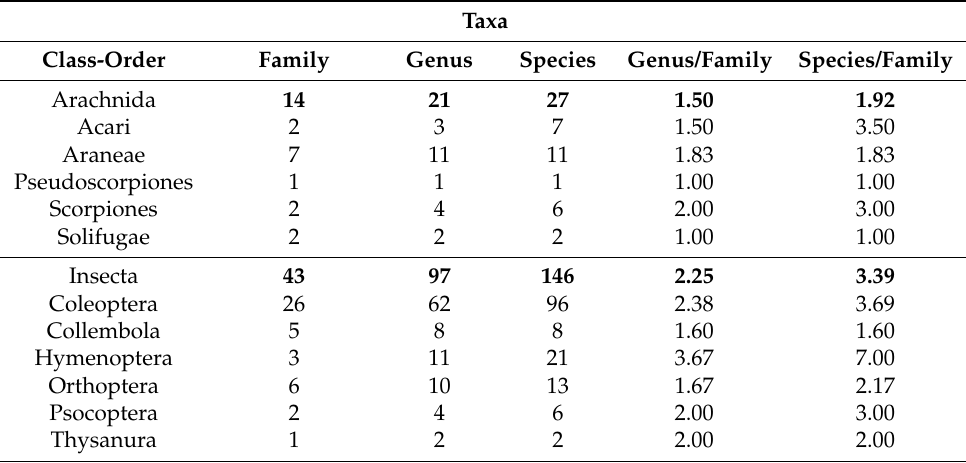
Table 2. Number of taxa (family, genus, and species) and ratios between the taxonomic levels of epigean arthropods from Paposo (Antofagasta Region, Chile). Taxa